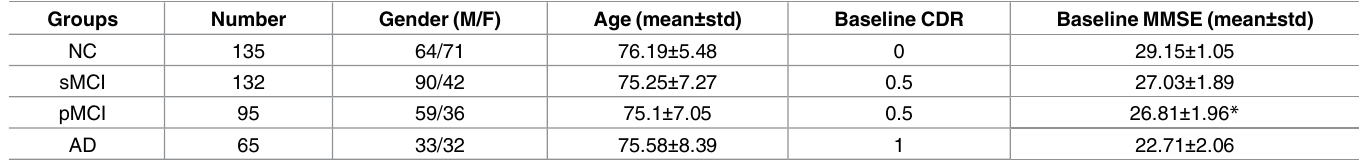
Table 1. Demographic information of the studied